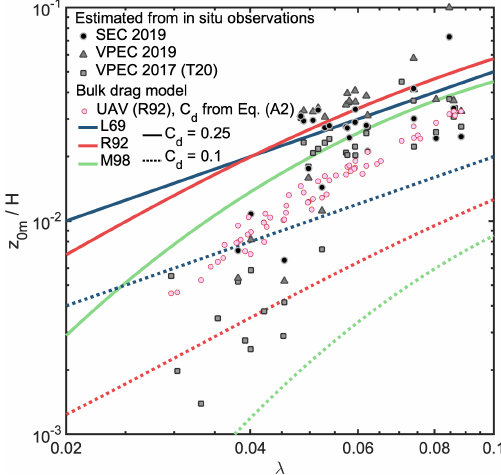
Figure 5. Modelled z 0m at site S5 using three different bulk drag models, Lettau (1969, L69, blue lines), Macdonald et al. (1998, M98, green lines), and Raupach (1992, R92, red lines), and using two different values for the drag coefficient for form drag: C d = 0 . 25 (solid lines) and C d = 0 . 1 (dashed lines). Solid grey sym- bols are measurements from sonic eddy covariance (SEC) or ver- tical propeller eddy covariance (VPEC). Additional data are from Van Tiggelen et al. (2020, T20). Pink circles are the model results forced with H and λ from UAV photogrammetry, using the R92 model and C d parameterized using Eq.